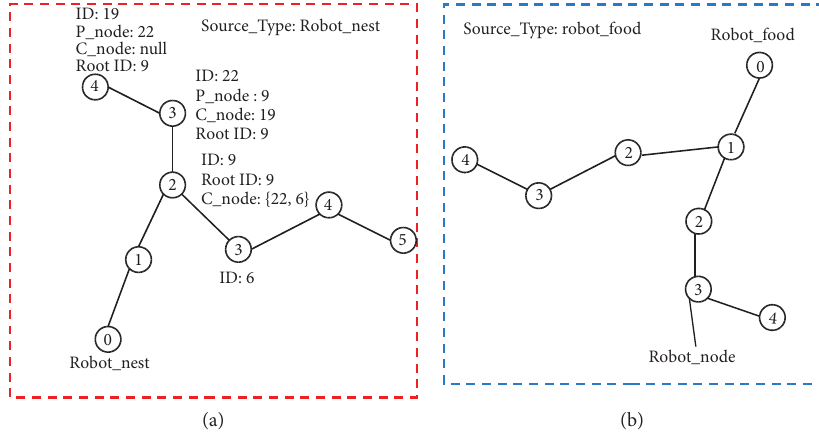
Figure 6: An illustration of the gradient mechanism. During the search process, two independent network structures will gradually be formed, as shown in the blue dotted box and red dotted box, where the numbers represent the gradient value of each